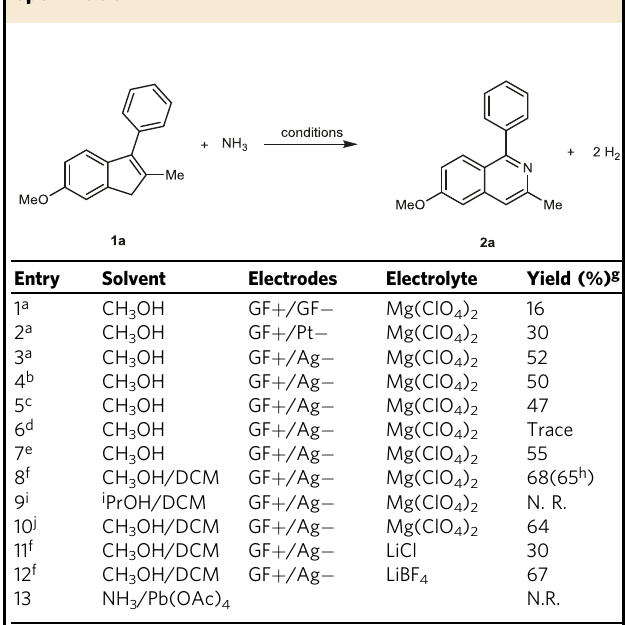
Table 1 Initial model reaction of ammonia insertion and